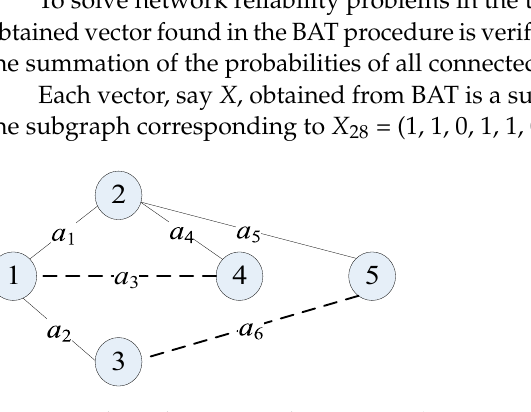
Figure 2. Subgraph corresponding to X 28 = (1, 1, 0, 1, 1, 0).